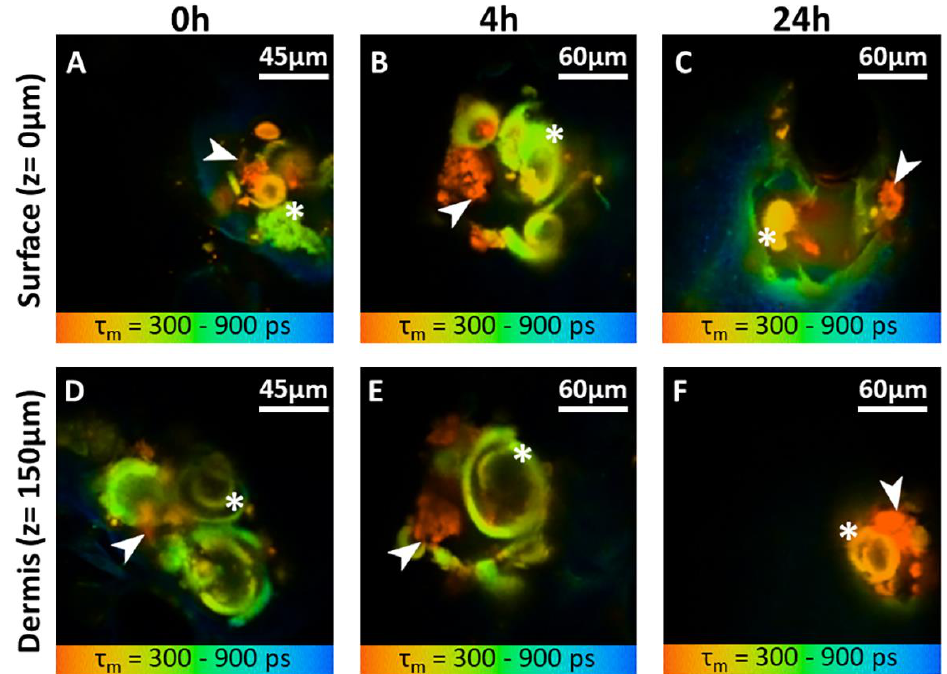
Figure 5. En-face (X-Y scans) MPT-FLIM images (mean fluorescence lifetime τ m in the 300–900 ps range) of microchannels created by PRN-loaded MN at different time points (0 h, 4 h and 24 h) and at two different depths (skin surface and 150 µm). The deposition of PRN and dissolved polymer from PRN-loaded MN in microchannels (760 nm excitation) at the surface of the skin z = 0 ( A – C ) and dermis at the depth of 150 µm ( D – F ) at different time points. Orange coloration indicates the aggregation of retinal ( arrowhead ) surrounded by a dissolved polymer and nanocarriers, shown in yellow-green (asterisk; *) . All images were acquired at 20 mW and 760 nm.